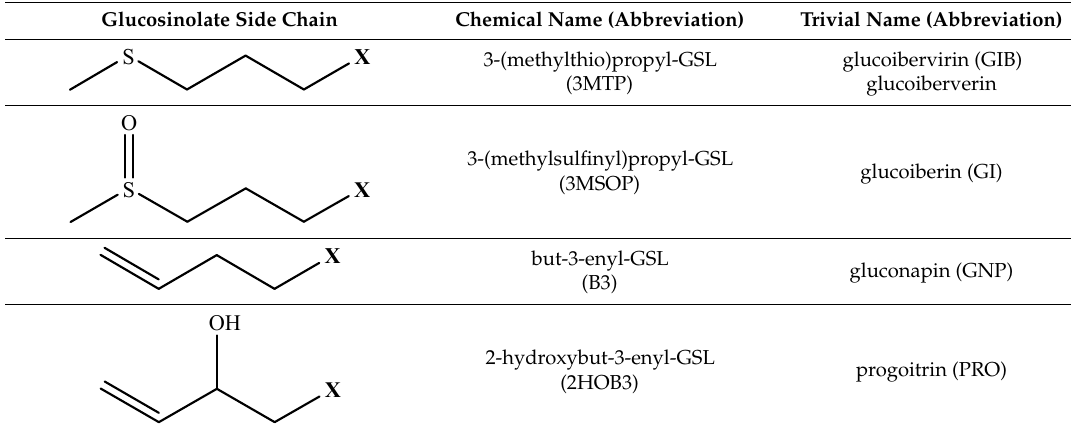
Table S1. Quantitative Real Time PCR (qRT-PCR) primers used for quantifying glucosinolate biosynthetic and hydrolysis-related gene transcript abundance in Raphanus sativus . Figure S1. Selenium isotope clusters for the tentatively identified 4MSeB3 pseudomolecular ion and its major selenium-containing daughter ion. Figure S2. EI-MS fragmentation patterns of the two isomers of 4MTB3-ITC. Figure S3. EI-MS fragmentation patterns of the two isomers of the proposed compound 4MSeB3-ITC.